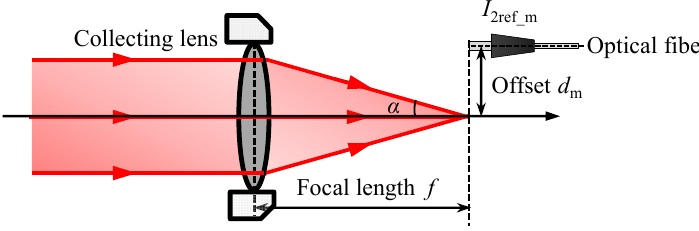
ff -axis detector shift d m in the newly proposed